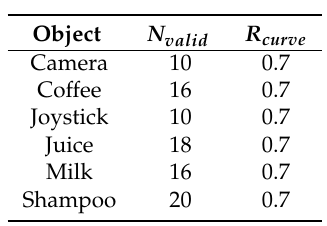
Table A2. Parameters of the Tejani